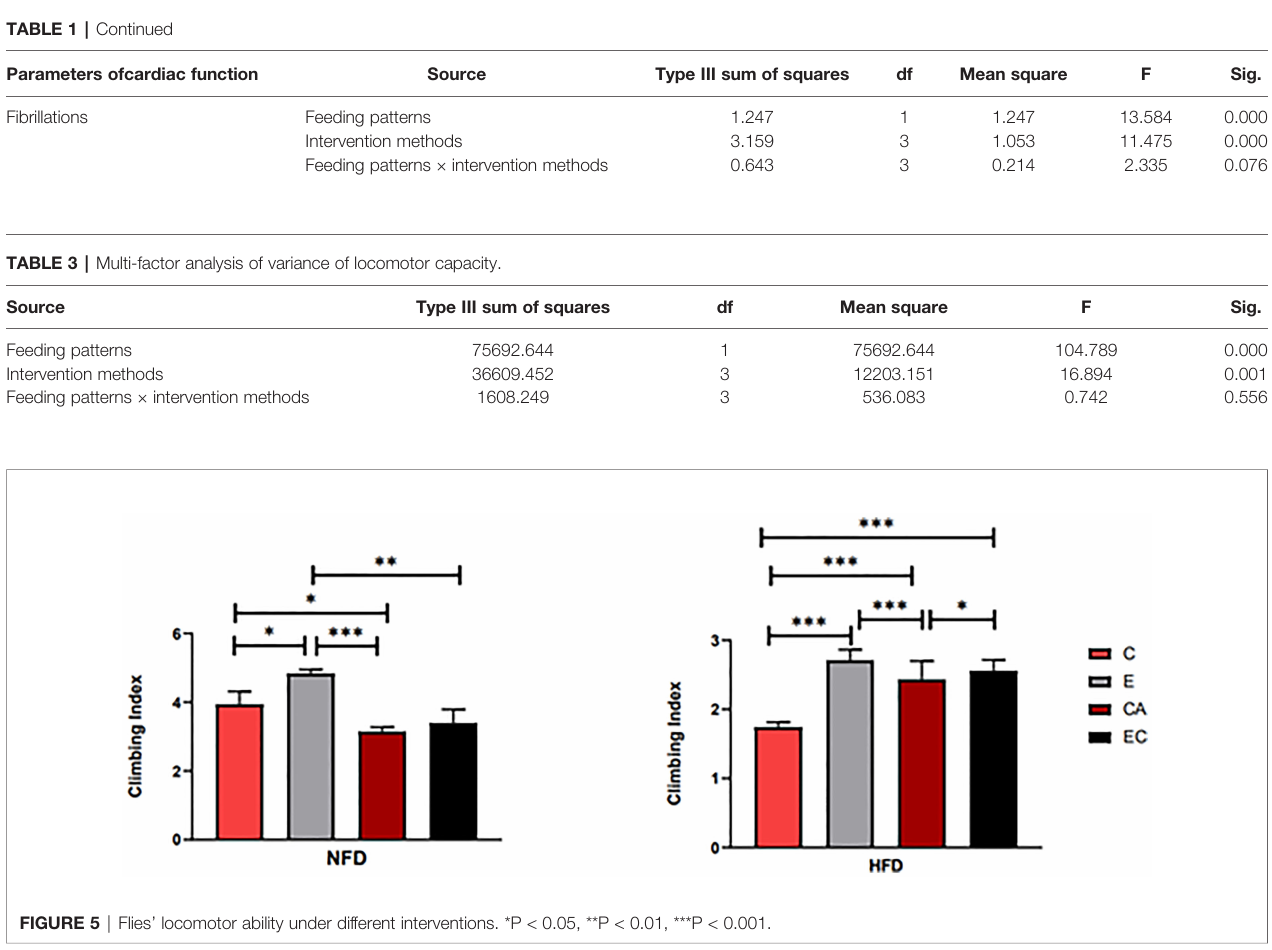
FIGURE 5 | Flies ’ locomotor ability under different interventions. *P < 0.05, **P < 0.01, ***P < 0.001.